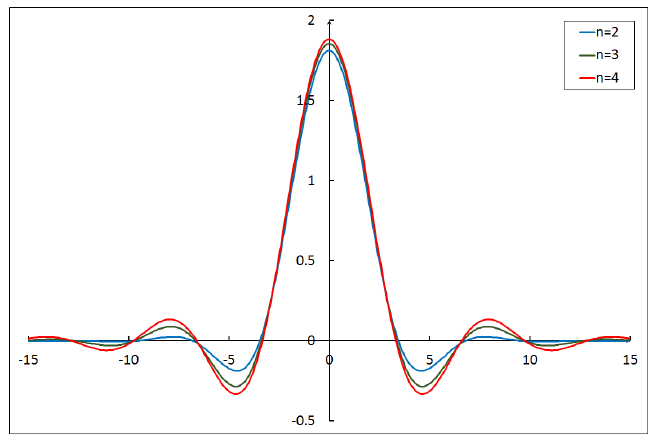
(cid:82) + ∞ d ξ e − ξ 2 n + iw ξ ( n = 2,3,4) evolves with a change of − ∞